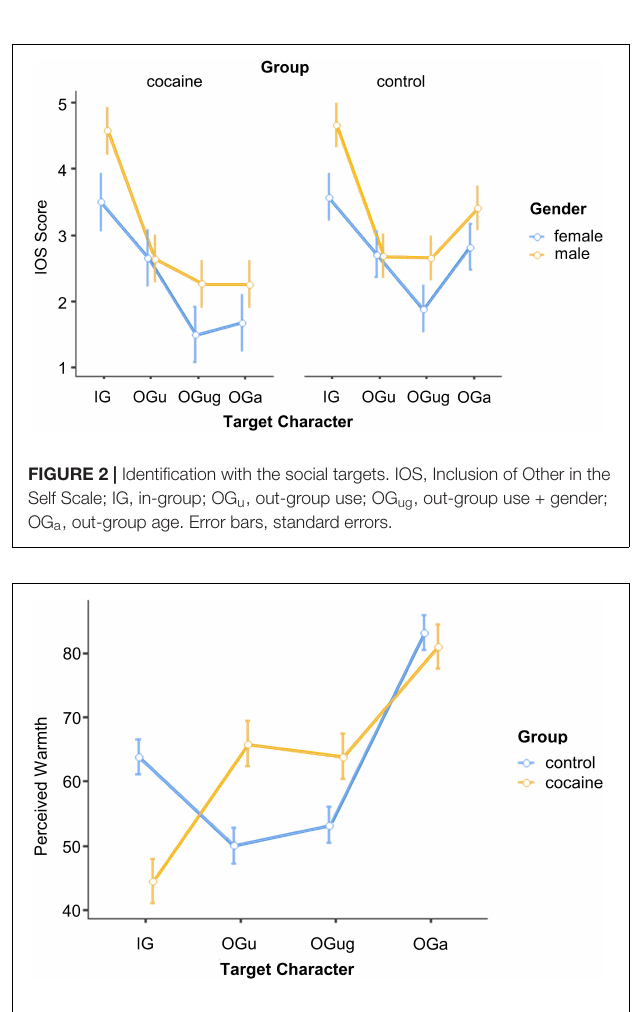
FIGURE 3 | Perceived warmth of the different social targets. IG, in-group; OG u , out-group use; OG ug , out-group use + gender; OG a , out-group age. Error bars, standard errors.